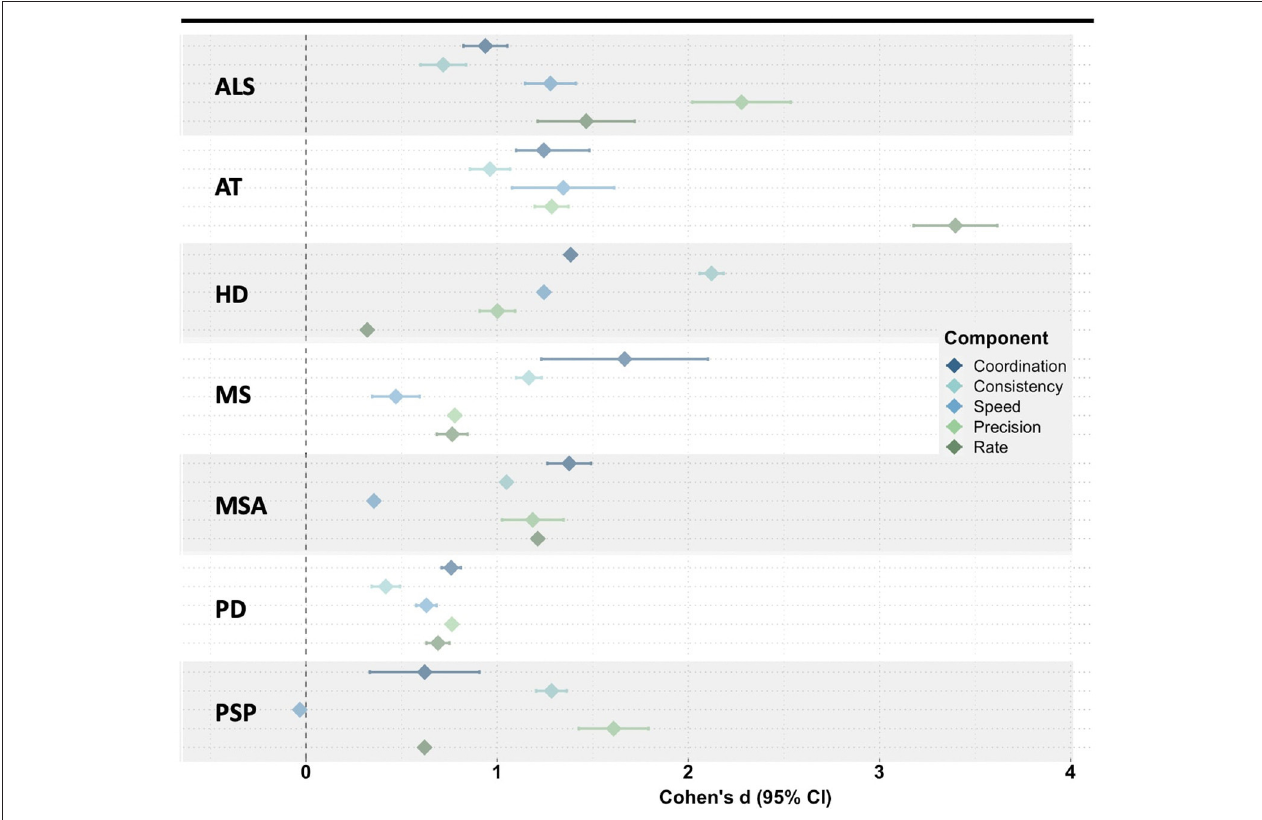
FIGURE 2 | Meta-analysis of the mean effect size (disease group compared to healthy controls) for all acoustic features within each articulatory component. ALS, amyotrophic lateral sclerosis; AT, ataxia; HD, Huntington’s disease; MS, multiple sclerosis; MSA, multiple systems atrophy; PD, Parkinson’s disease; PSP, progressive supranuclear